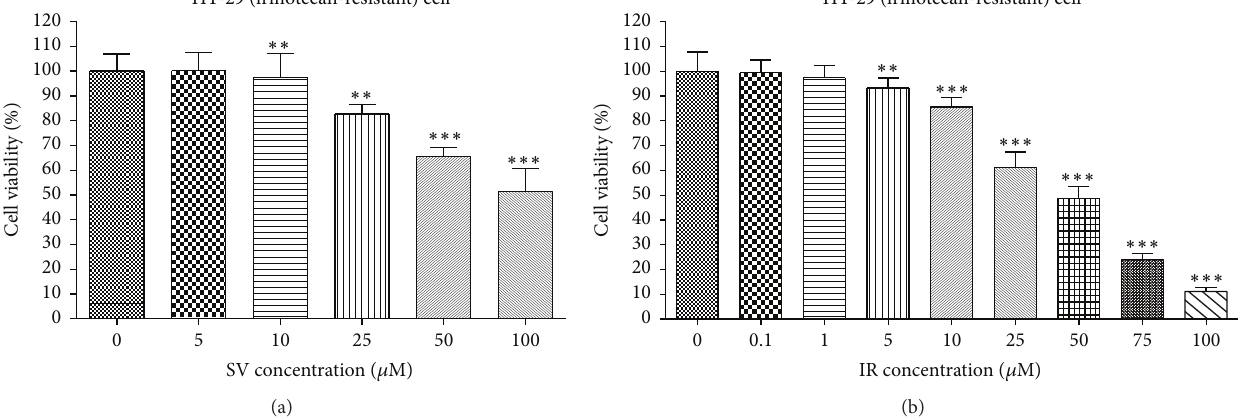
Figure 2: Effect of simvastatin or irinotecan alone on cell viability in irinotecan-resistant HT-29 cell. Human colon cancer cells HT-29 with irinotecan resistance were treated with serial concentrations of simvastatin (SV) and irinotecan (IR) for 48h in 96-well plates, and cell viability was measured by MTT assay, respectively (a, b). The data are expressed as the means ± SD from three independent experiments. ∗∗∗ 𝑃 < 0.001 , compared to untreated control cells; ∗∗ 𝑃 < 0.05 , compared to untreated control